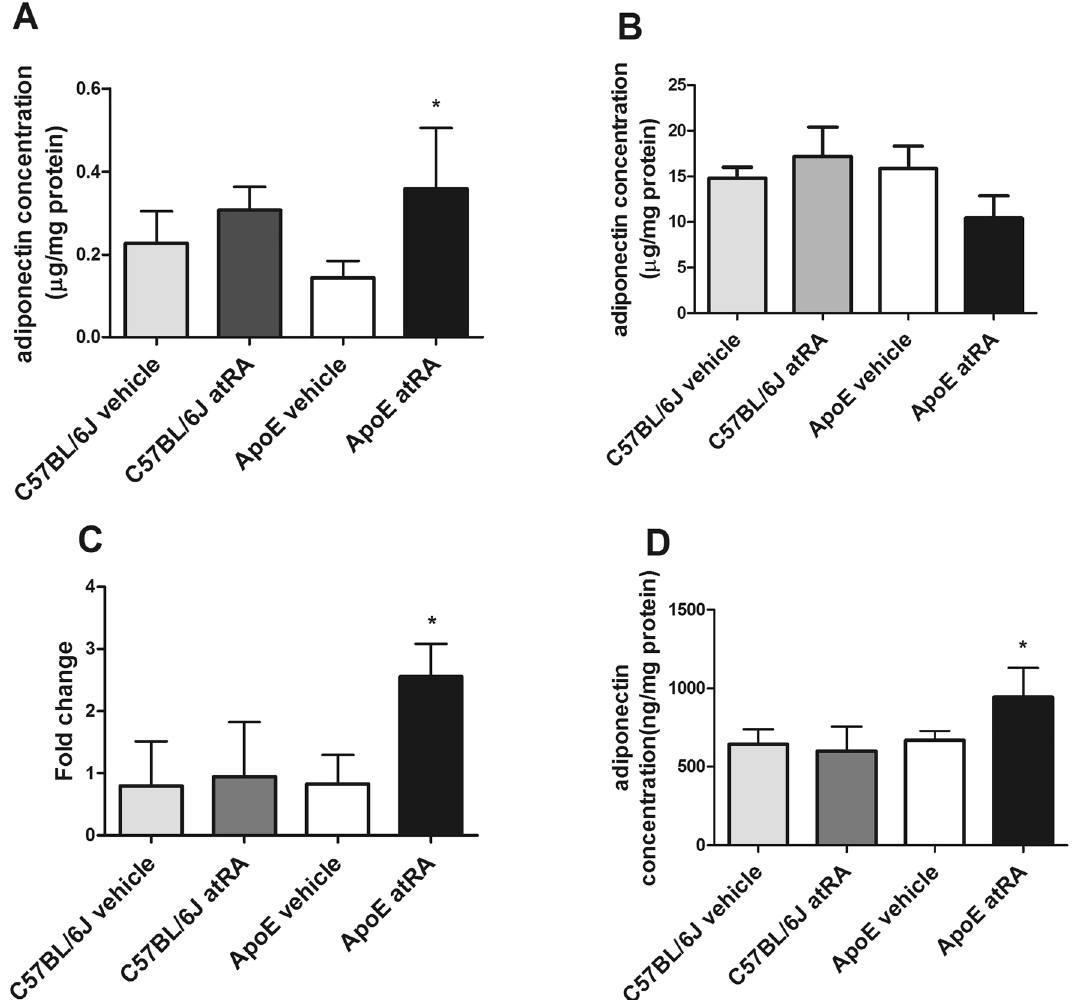
Figure 4. The all-trans-retinoic acid treatment increased adiponectin synthesis and secretion by perivascular adipose tissue. ( A ) Adiponectin concentration in perivascular adipose tissue. ( B ) Adiponectin concentration in visceral adipose tissue. ( C ) mRNA adiponectin level in perivascular adipose tissue. ( D ) Adiponectin concentration in the conditioned medium after 24 h incubation with perivascular adipose tissue explants. All-trans-retinoic acid (5 mg/kg/day) or vehicle (corn oil) were administered orally by plastic feeding tubes to Apo-E and C57BL/6J mice for 8 weeks. Data are shown as mean ± SEM of 5–6 mice per group. The results were analyzed by one-way ANOVA with Tukey’s Multiple Comparison Test. *p < 0.05 ApoE atRa vs. ApoE